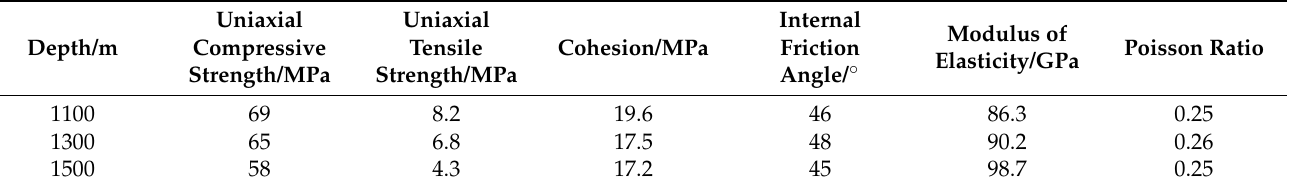
Figure 3. Main process of equivalent rock mass